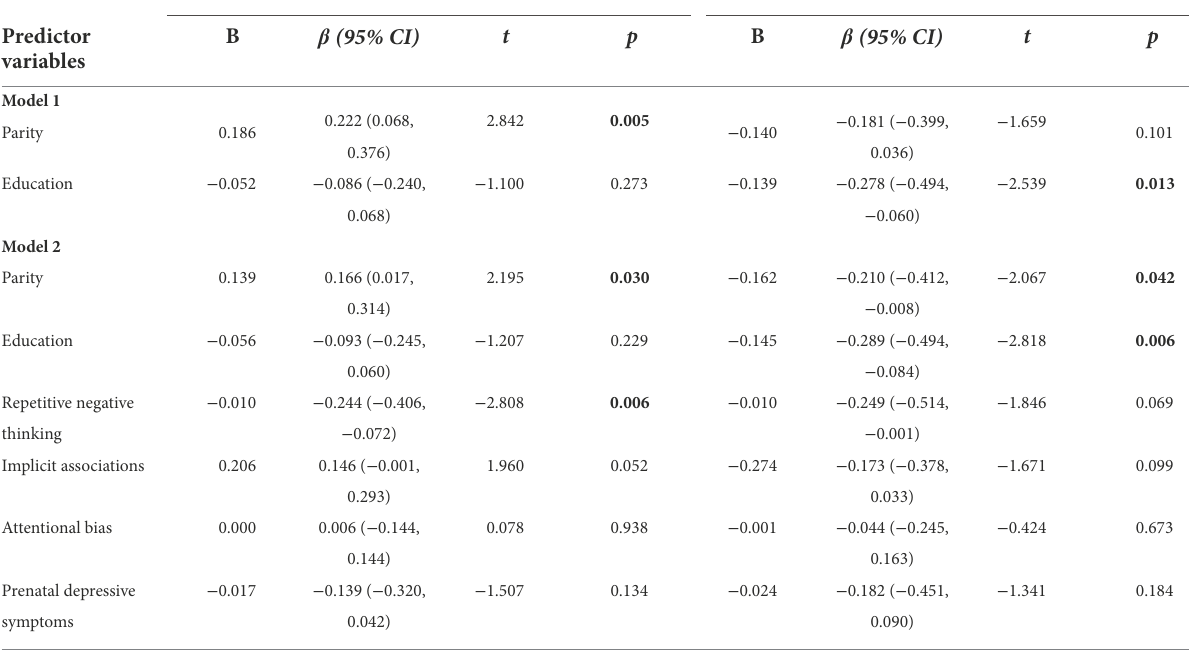
TABLE 4 Results of hierarchical regression predicting bonding in mothers and fathers.